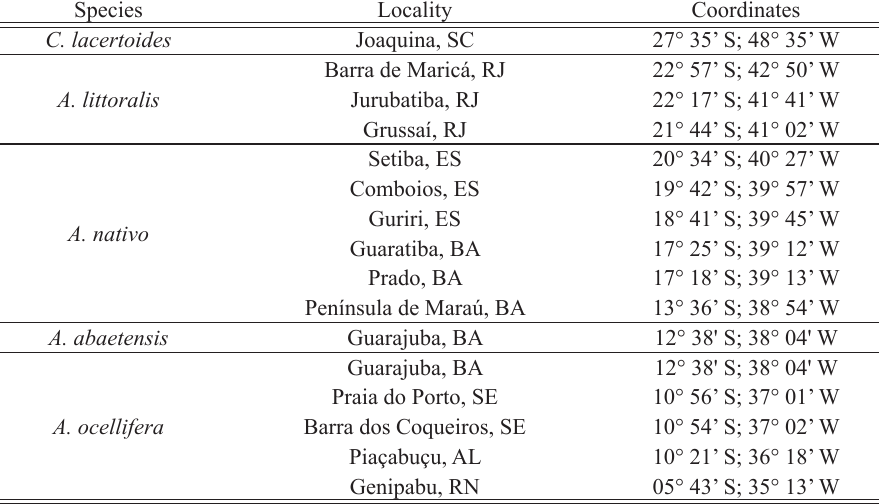
Figure 2 - Geographic distribution of the five cnemidophorine species living in restinga habitats along the eastern coast of Brazil. Brazilian State codes are: SC - Santa Catarina, RJ - Rio